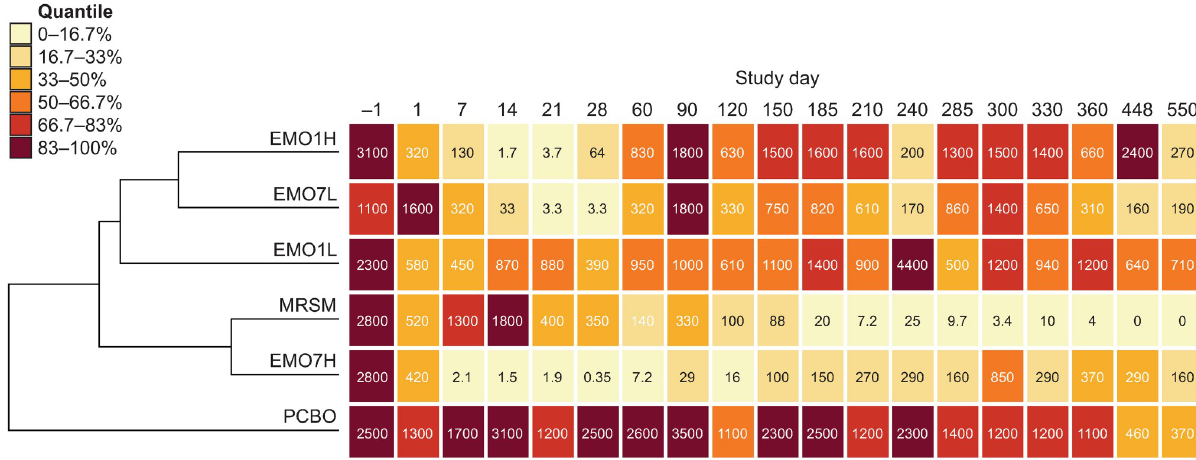
Fig 4. Mean dermal microfilarial density ( n per 100 mg skin) in zebu (Ngaounde´re´ Gudali) cattle ( B . t . indicus ) treated with emodepside or melarsomine compared with placebo. Mean dermal microfilarial density was determined by incubation of skin biopsies (in triplicate per animal, per timepoint) normalized to 100 mg skin [59]. Mean density values are shown at each timepoint in each treatment group ( n = 7 per group) and are color- coded by quantile, from pale yellow (low microfilarial density) to dark red (high microfilarial density). The dendrogram was created by hierarchical clustering based on Euclidean distance between mean dermal microfilarial density profiles and indicates the degree of similarity between treatments based on the in vivo response over time. No between-group statistical comparisons were made. EMO1H, emodepside, 0.75 mg/kg, single dose; EMO7H, emodepside, 0.75 mg/kg, daily for seven days; EMO1L, emodepside, 0.15 mg/kg, single dose; EMO7L, emodepside, 0.15 mg/kg, daily for seven days; MRSM, melarsomine, 4 mg/kg, every other day for three days; PCBO, placebo.